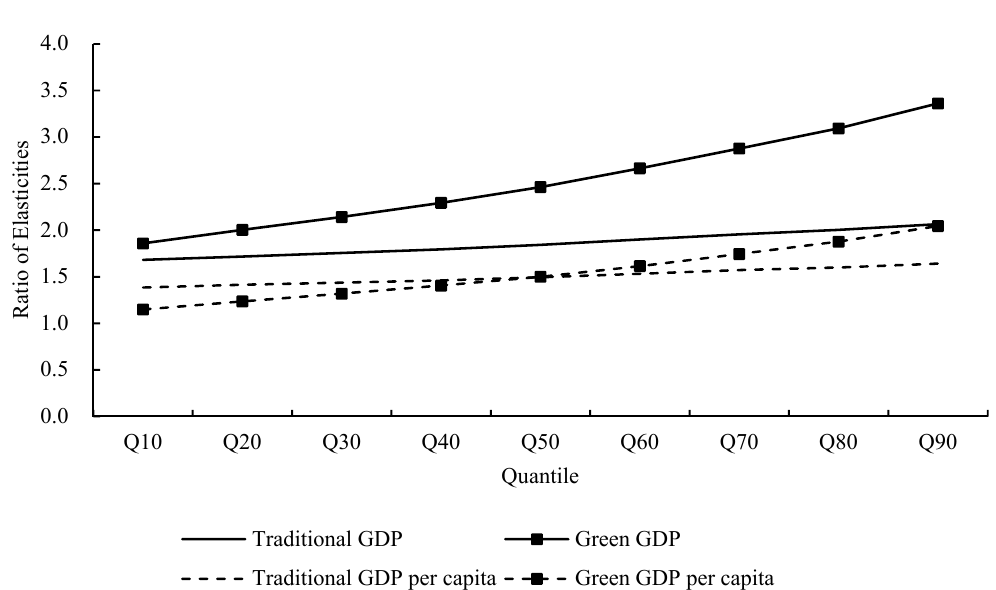
Figure 2. Ratios of elasticities of human capital to physical capital in the quantile regression models.